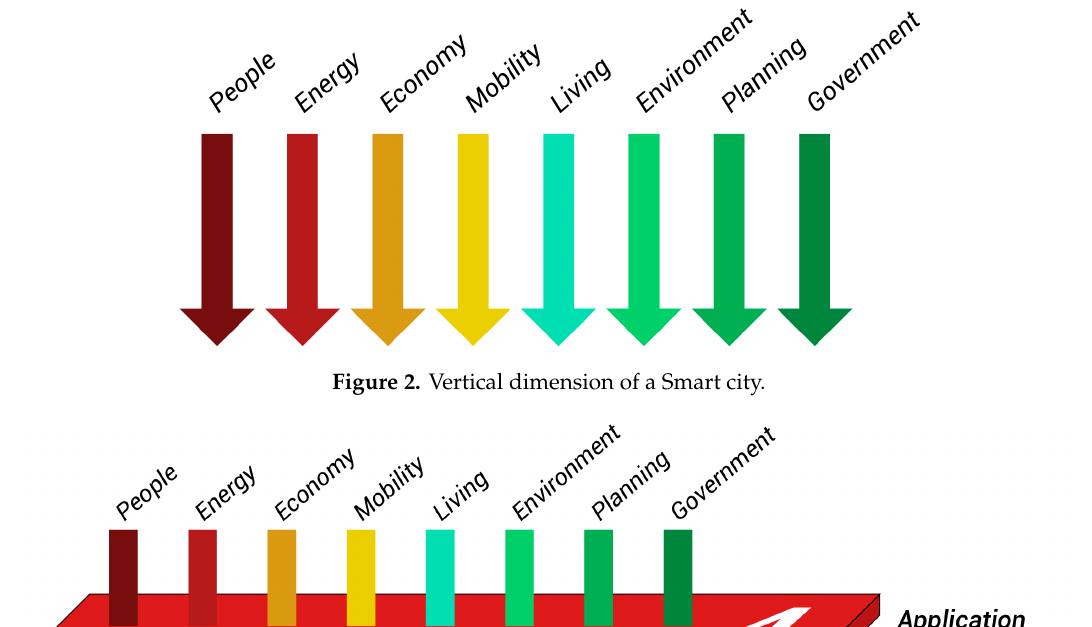
Figure 1 . Horizontal dimension of a Smart city .